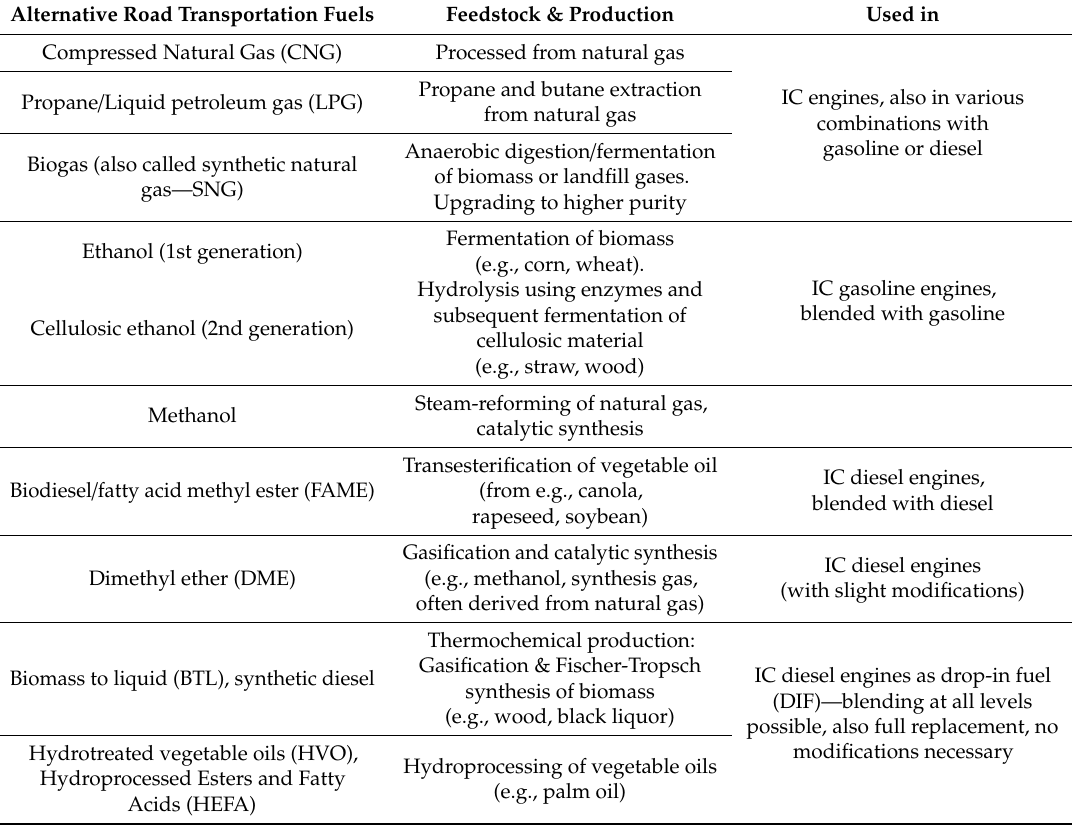
Table 1. Alternative road transportation fuels as defined in the reviewed papers (Source: [9]).